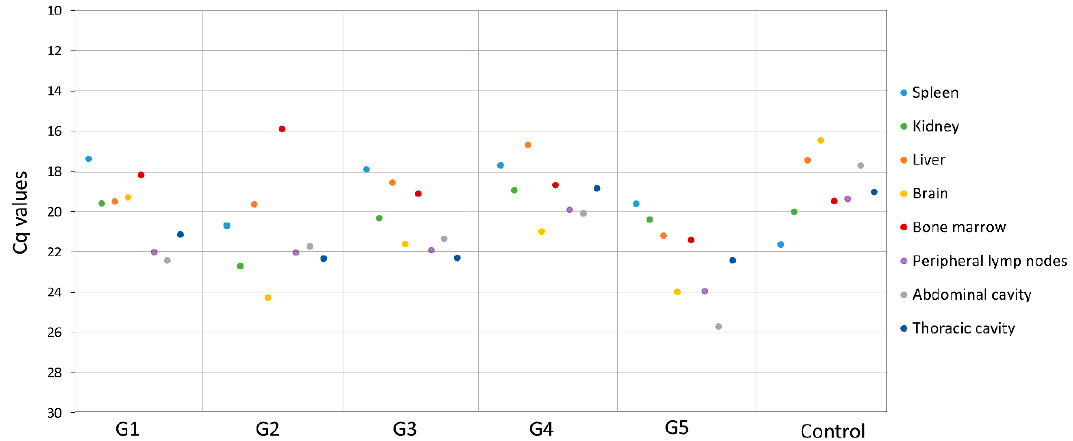
Figure 6. Mean of the cycles of quantification values (Cq) obtained by qPCR from the spleen, kidney, liver, brain, bone marrow, peripheral lymph nodes (submandibular, retropharyngeal, prescapular, and inguinal), abdominal cavity organs (urinary bladder, renal lymph node, gastrohepatic lymph node, and mesenteric lymph node) and thoracic cavity organs (heart, lung, and mediastinal lymph node) of the different study groups.